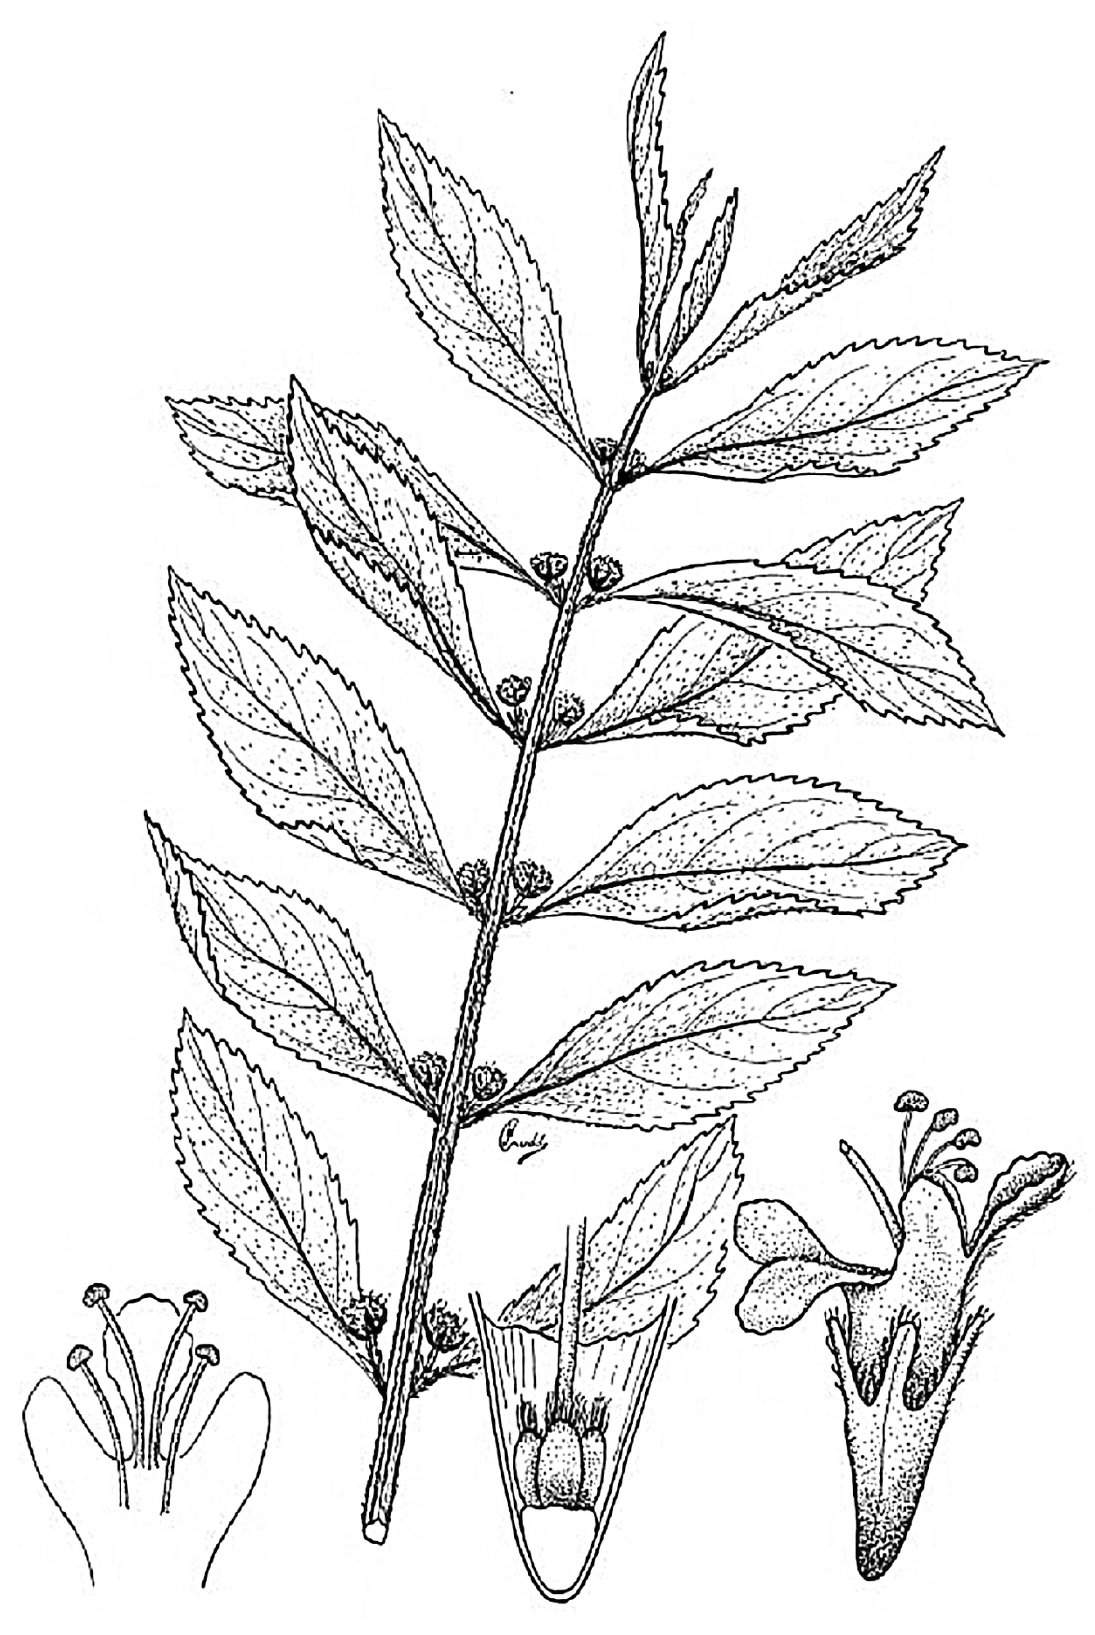
Figure 1. Hyptis obtusiflora [28].